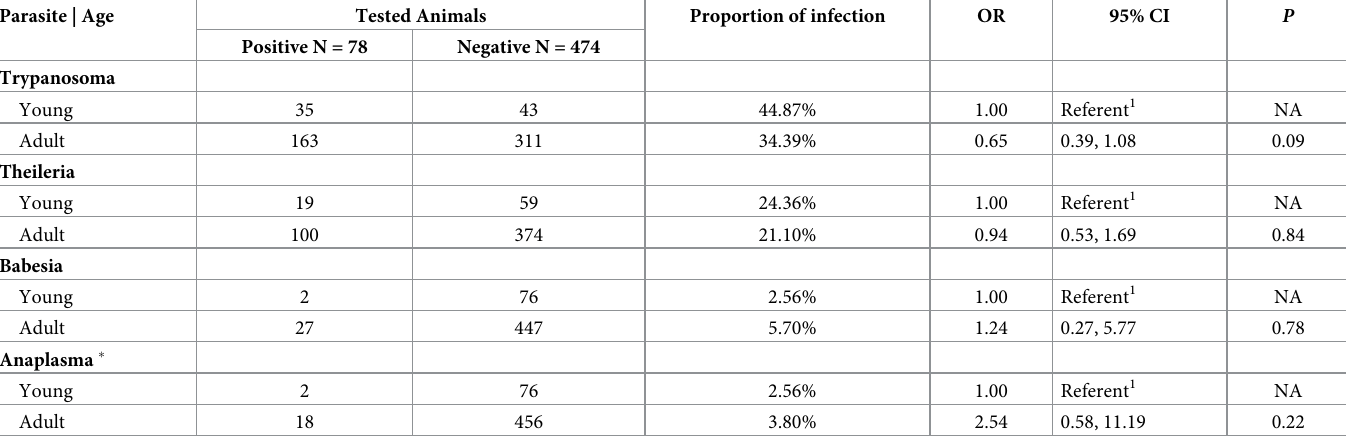
Table 2. The proportion of blood parasites infection according to the age of the animal and the conditional logistic regression for the odds of the infection in adults compared to young animals. Parasite | Age Tested Animals Proportion of infection OR 95% CI P Positive N = 78 Negative N =